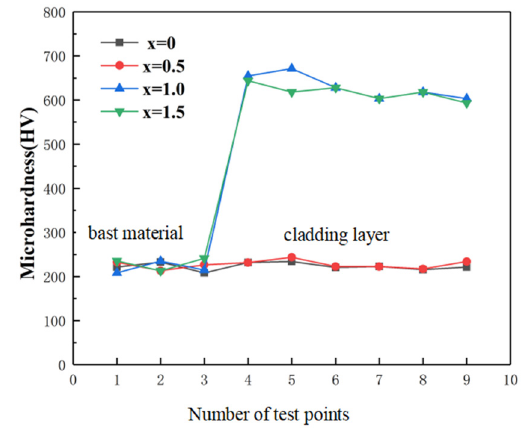
Figure 6. Hardness distribution of AlxFeCoCrNiMn high entropy alloy.